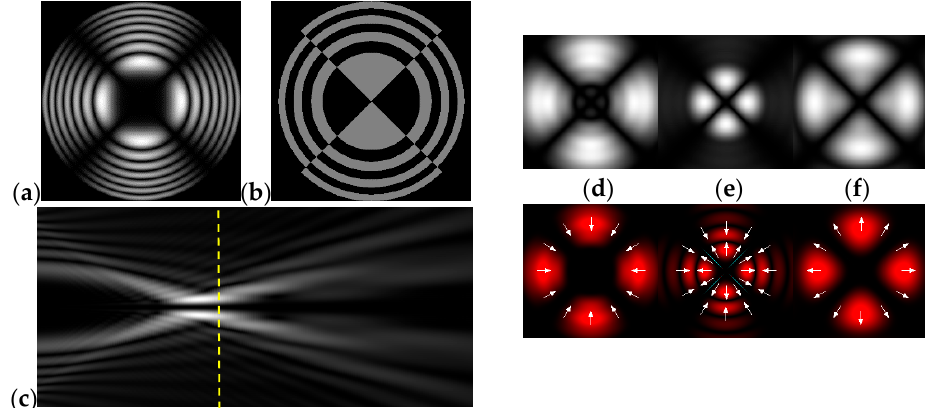
Figure 4. Simulation results for the field defined by Equation (17) with azimuthal modulation of the order of q = 2 (the rest of the description is as in Figure 2).